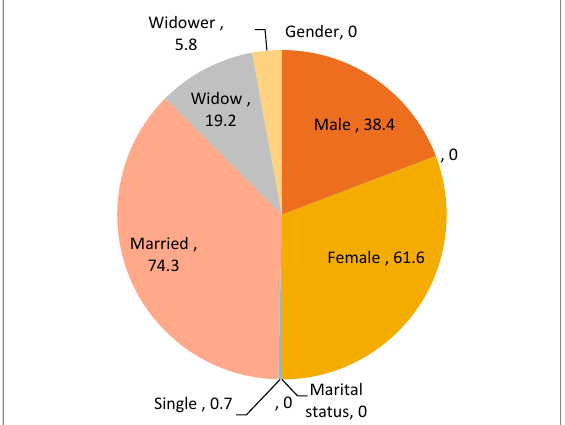
Figure 3. Gender and marital status of respondents.